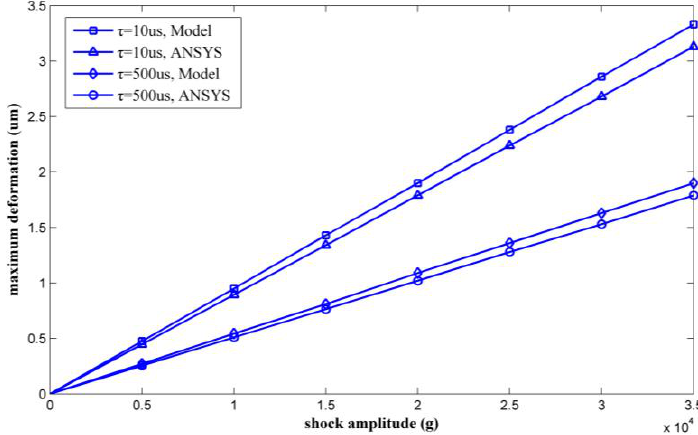
Figure 12. Maximum deformations as calculated by ANSYS and the proposed model versus shock load amplitude.